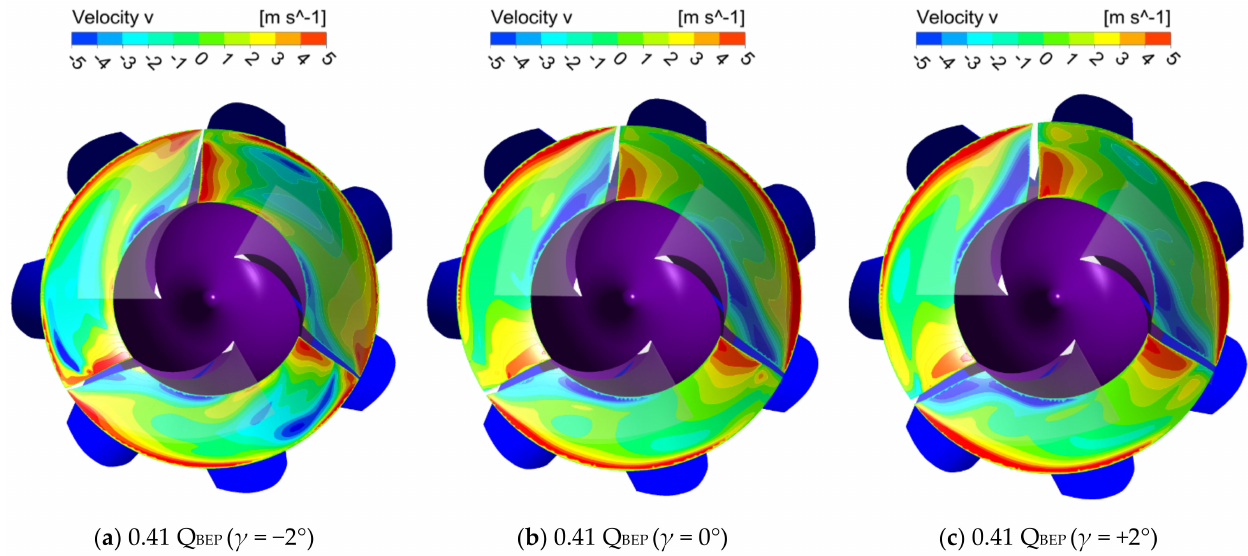
Figure 21. Axial velocity contours at the runner outlet for the three blade angles under deep part-load conditions (0.41 Q BEP